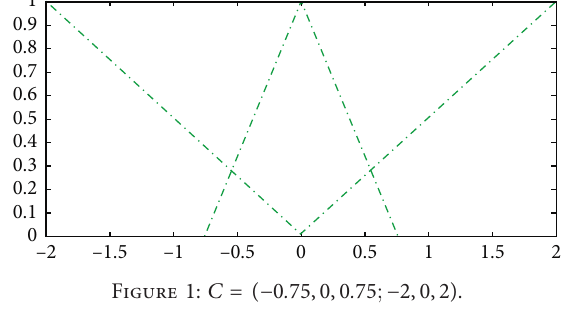
Figure 1: C � (− 0 . 75 , 0 , 0 . 75 ; − 2 , 0 , 2 ) .